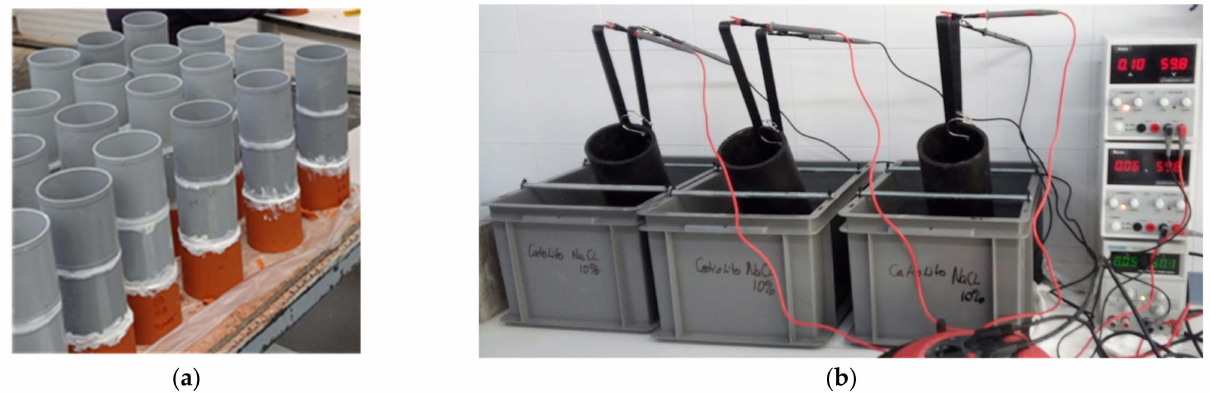
Figure 1. Chloride penetration methods: ( a ) NT BUILD 443 standard; ( b ) rapid chloride migration (RCM) test according to NT BUILD 492